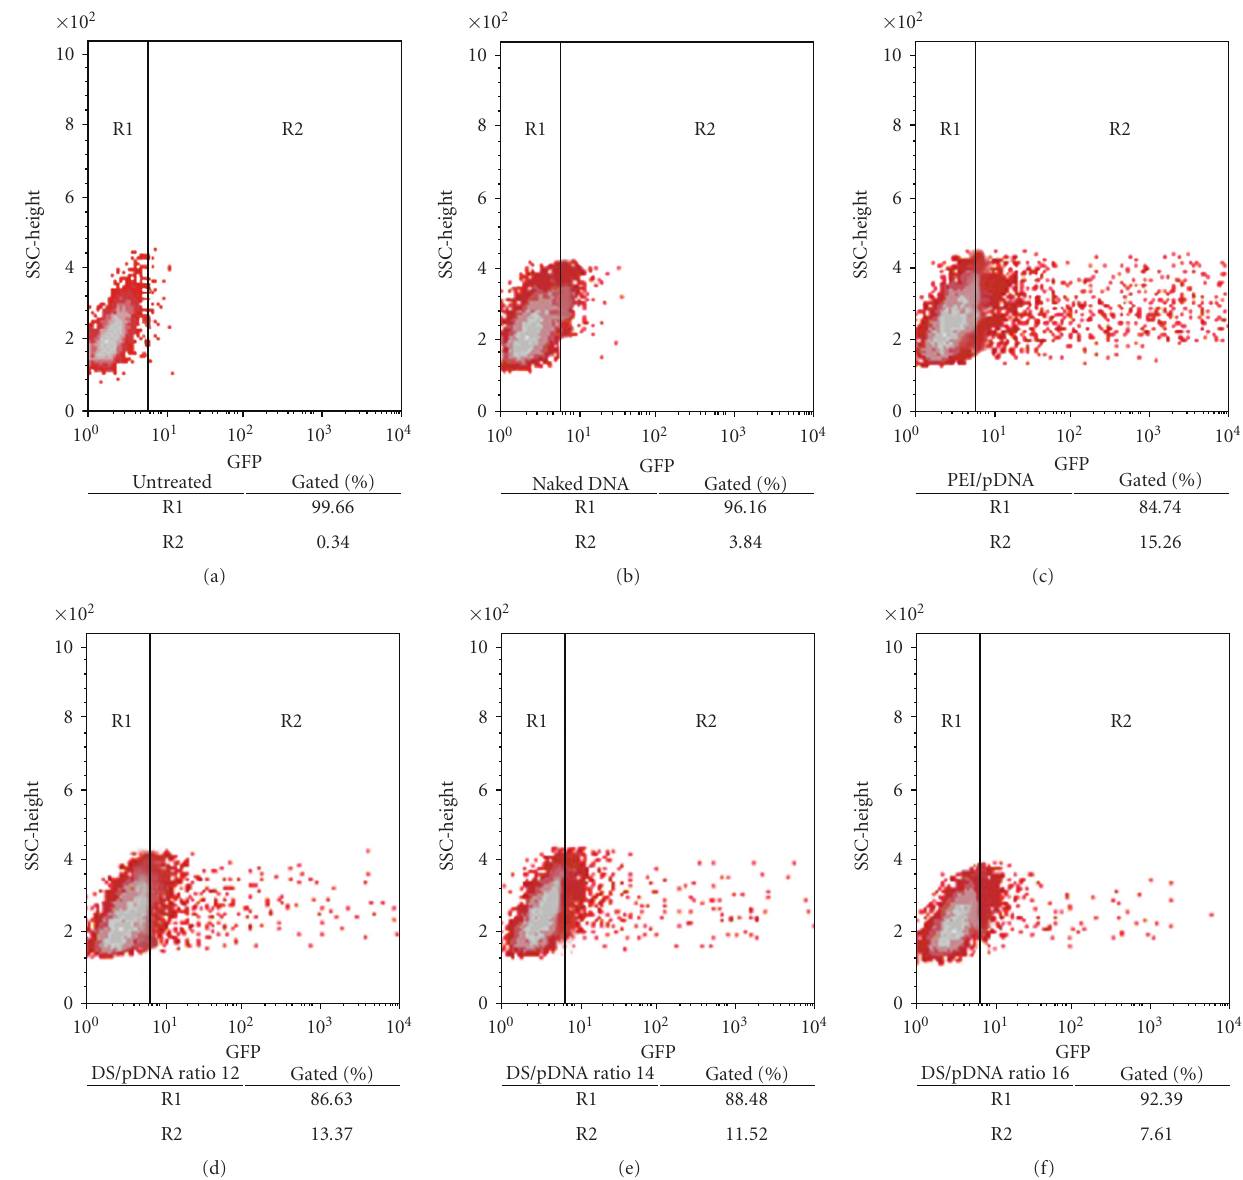
Figure 3: Side scatter (SSC) versus GFP fluorescent dot plot of transfected COS-7 cells showing positions of GFP-negative (R1) and GFP- positive (R2) population with the percentage gated of GFP-positive cells using flow cytometry analysis by using di ff erent gene carriers. Gene expression was measured at 48 h post-transfection. (a) Untreated, (b) naked DNA, (c) PEI/phMGFP, (d) D-SPM/phMGFP at ratio 12, (e) D-SPM/phMGFP at ratio 14, and (f) D-SPM/phMGFP at